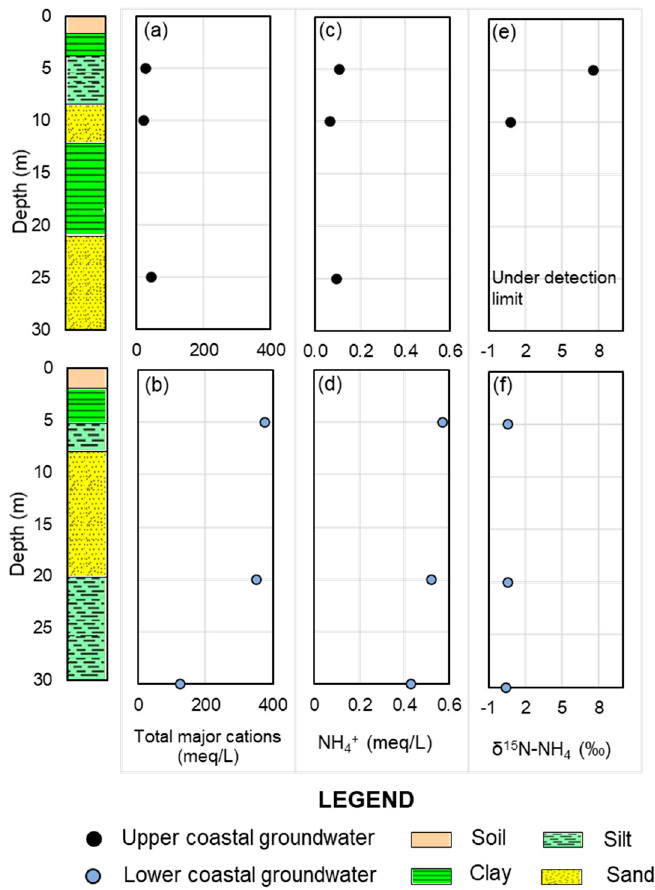
Figure 9. Average total major cations ( a , b ) (meq/L), NH 4+ contents (meq/L) ( c , d ), and δ 15 N NH4 values (‰) ( e , f ) in three depths of groundwater in upper and lower coastal areas.